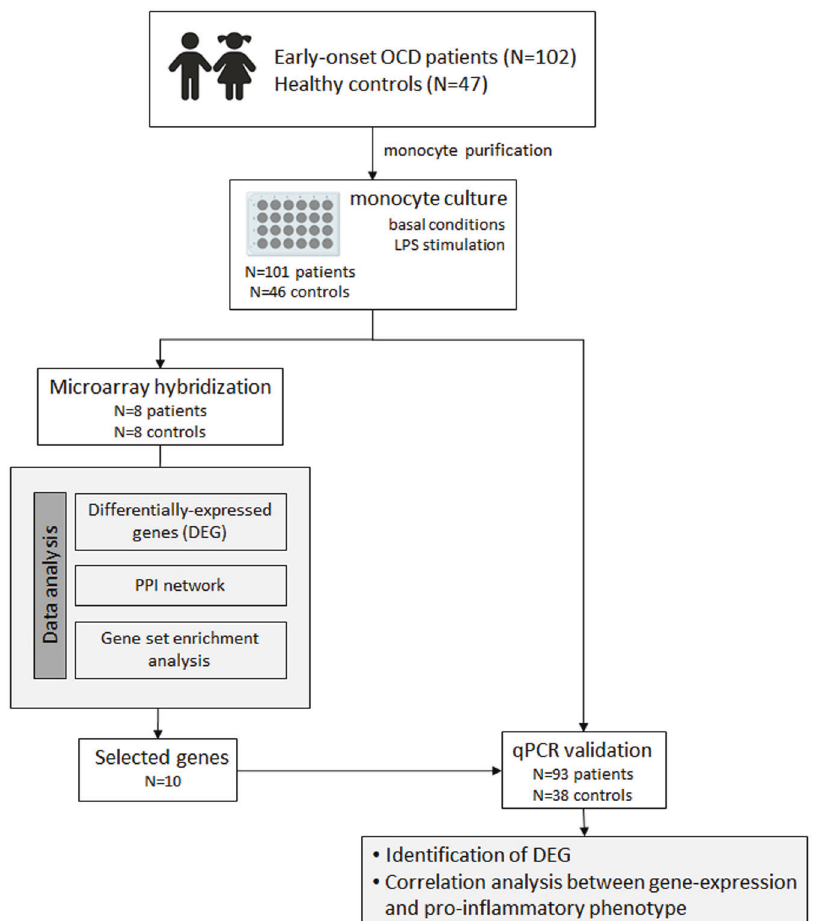
Fig. 1 Overview of the study. DEG differentially expressed genes, LPS lipopolysaccharide, OCD obsessive-compulsive disorder, PPI protein- protein